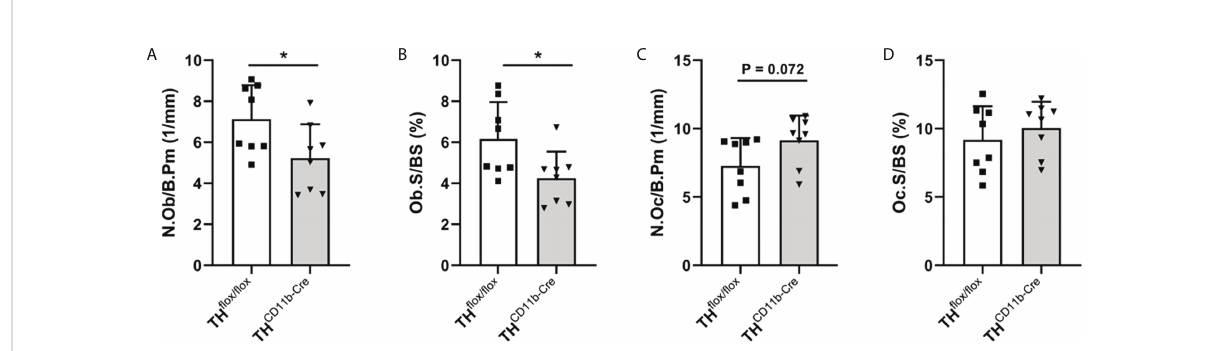
FIGURE 4 Bone cells in twelve-week-old TH CD11b-Cre mice. (A) Number of osteoblasts per bone perimeter (N.Ob/B.Pm), (B) osteoblast surface per bone surface (Ob.S/BS), (C) number of osteoclasts per bone perimeter (N.Oc/B.Pm) and (D) osteoclast surface per bone surface (Oc.S/BS) in femora of twelve-week-old TH fl ox/ fl ox and TH CD11b-Cre mice. n = 8; *P < 0.05.